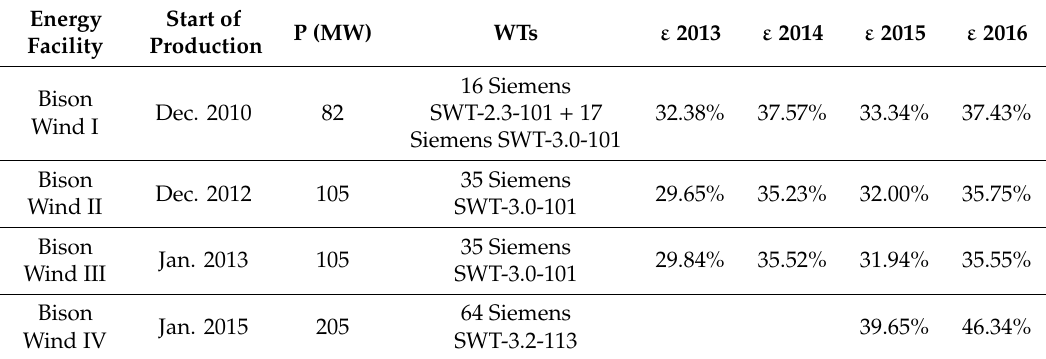
Table 6. Bison Wind Energy Center